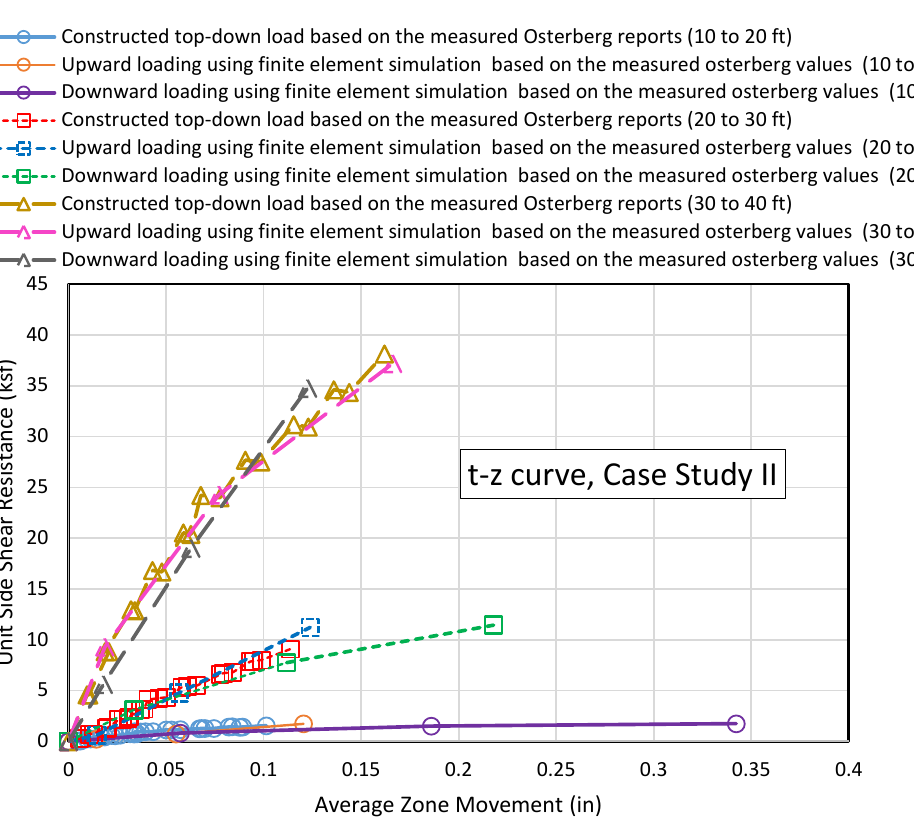
Figure 12. t – z stiffness curve for the constructed top-down load, along with the upward and downward axial load finite element simulation in Case Study II.